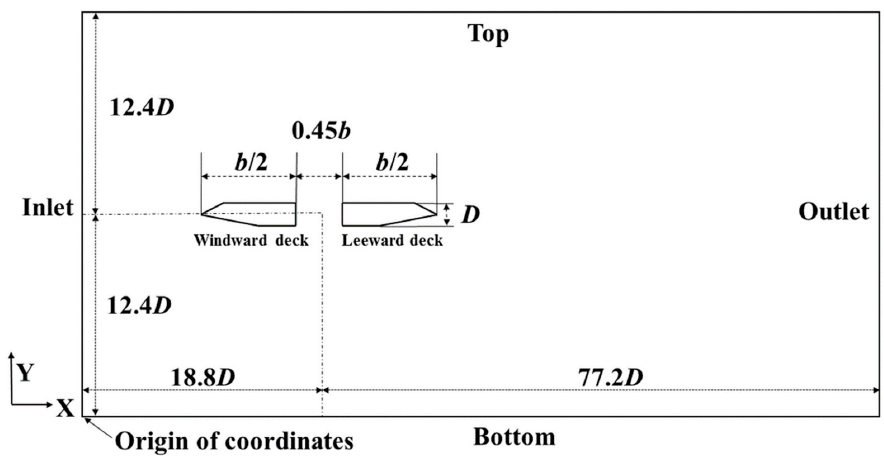
Figure 2. Computational domain and boundary conditions for the case of the angle of attack +0.1°, D = 0.0625 m in the model test.